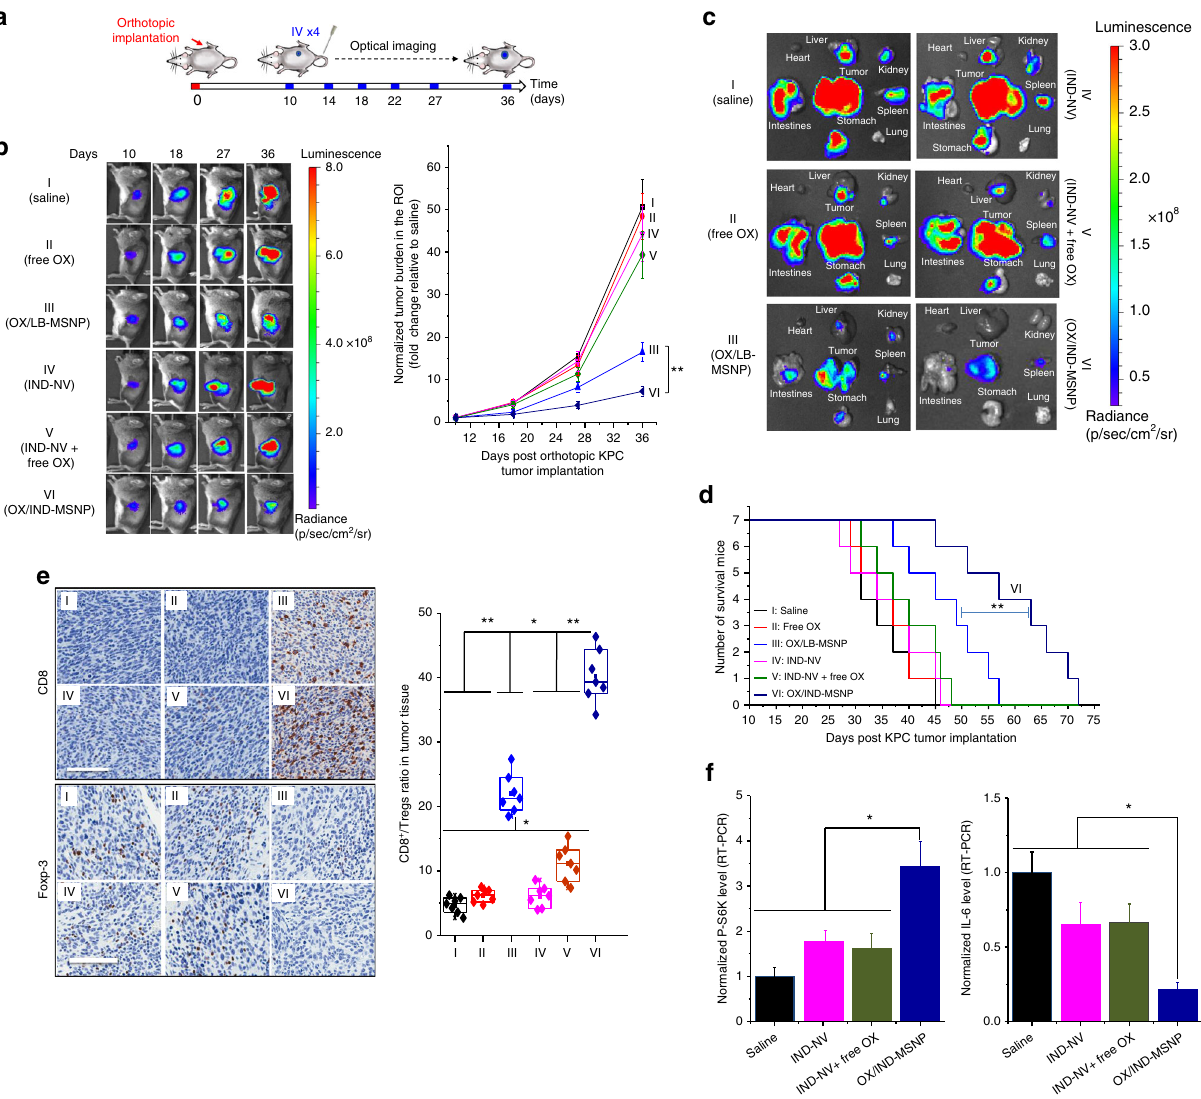
Fig. 6 Dual delivery of OX plus IND-NV by MSNP induced effective anti-PDAC immunity in the orthotopic tumor model. a Orthotopic tumor-bearing B6/ 129 mice ( n = 7) were IV injected with the OX/IND-MSNP to deliver the equivalent 5 mg/kg OX and 50 mg/kg IND every 4 days, for a total of 4 administrations. The 1 st injection started on day 10. Free OX, OX/LB-MSNP, IND-NV, IND-NV + free OX, and OX/IND-MSNP were used for comparison at the equivalent doses. Interval IVIS imaging monitored tumor growth, which was quantitatively expressed as image intensity at the ROI. b Representative IVIS imaging on days 10, 18, 27, and 36, according to which the normalized tumor burden was plotted as fold-increase compared to the non-treated control. c Representative ex vivo bioluminescence imaging on day 36 to show the effect of treatment on metastatic tumor spread to the stomach, intestines, liver, spleen, kidneys, diaphragm, and abdominal wall, but not the heart or lung. We also included in the same experiment, treatment with anti-CD8 and anti- TLR4 antibodies, as well as an injectable pool of siRNAs for knockdown of CD91. The effect of interference in the immune response is shown in Supplementary Fig. 12a. The corresponding heat map display of the ex vivo imaging is summarized in Supplementary Fig. 10b. d Assessment of the survival effect of OX/IND-MSNP ( n = 7) vs. the controls was conducted by repeating the experiment in ( a ). e IHC staining for CD8 + and Foxp3 + T cells in tumor tissue, collected in c (left panel). Scale bar is 100 μ m. CD8/Tregs ratio in tumor tissue determined by fl ow cytometry (right panel). f Real-time PCR measurement of P-S6K and IL-6 mRNA expression as a result of interference in the IDO pathway in vivo. The results are expressed as mean ± SEM. * p < 0.05; ** p < 0.01. (ANOVA for Fig. 6b, e, f; Log-rank Mantel – Cox test for Fig.